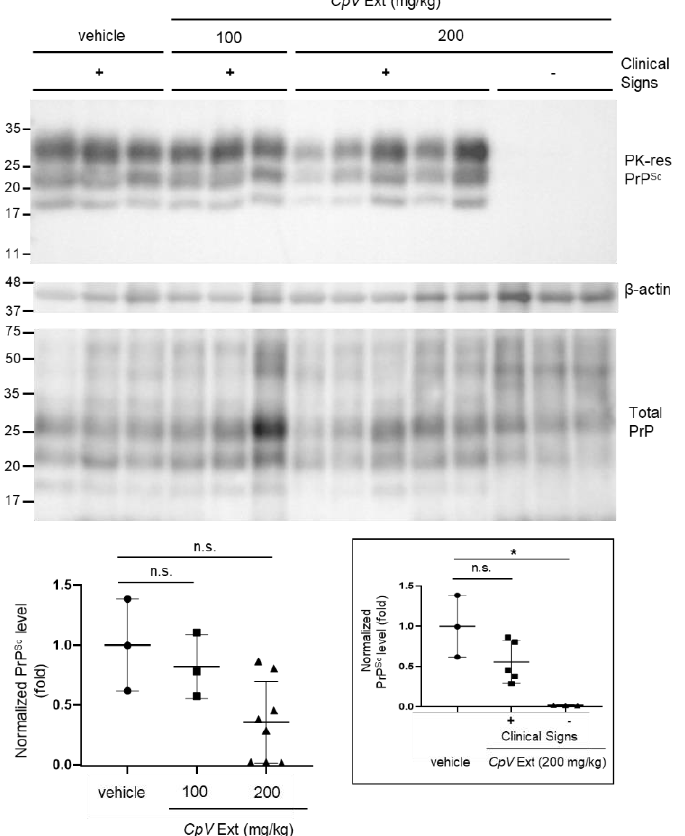
Figure 6. Decrease in PrP Sc in the spleens of prion-infected mice that received CpV extract. The level of PK-resistant (PK-res) PrP Sc in the mouse spleens of each group collected at the end point of individual mouse. β -actin was used a loading control. Total PrP was detected from spleen homogenate without PK digestion. The western blot of PK-res PrP Sc was quantified by densitometry. The PrP Sc level normalized with the β -actin level was plotted and compared between control and each treated group. The subgroups with (+) or without ( − ) clinical signs within 200 mg/kg group were divided and compared individually with the control group (inset). n.s., statistically not significant; *, p = 0.011.